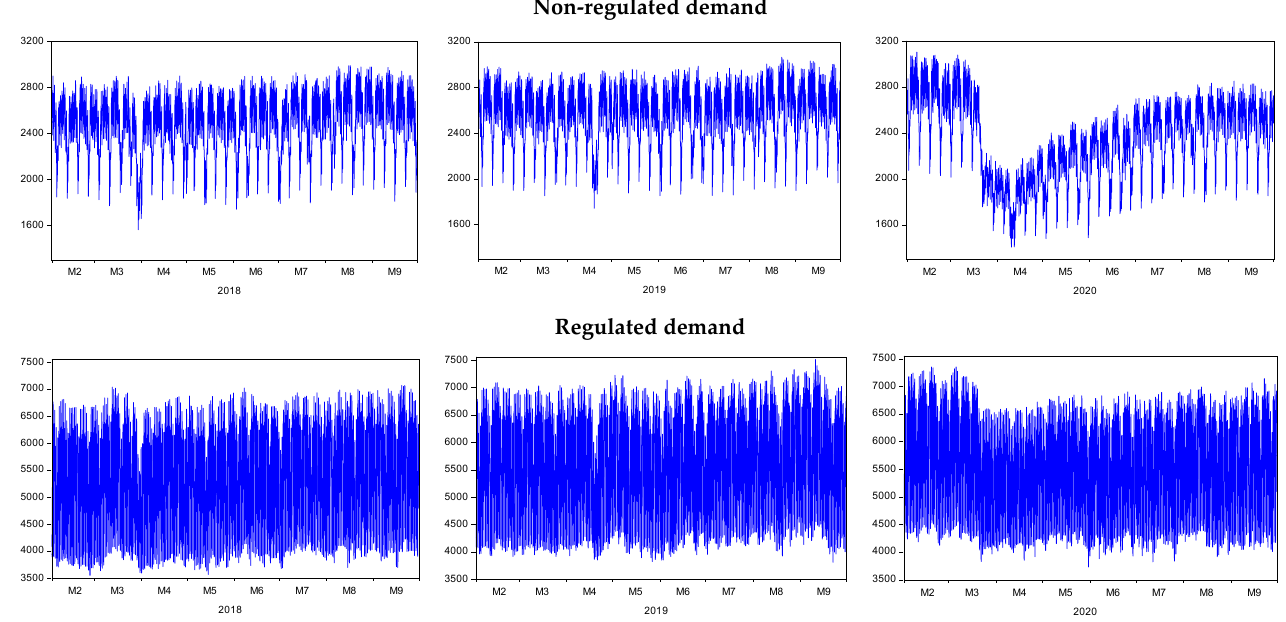
Figure 1. Evolution of the electricity demands for February–September of 2018–2019–2020.